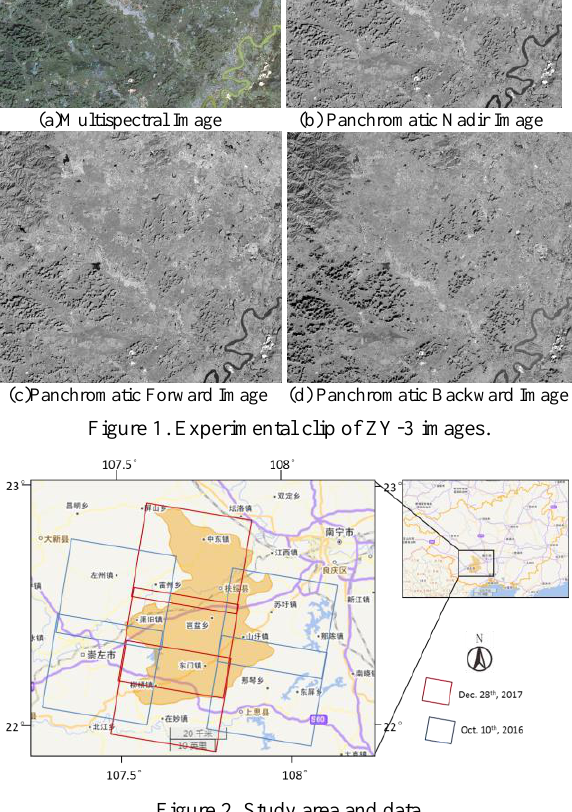
Figure 2. Study area and